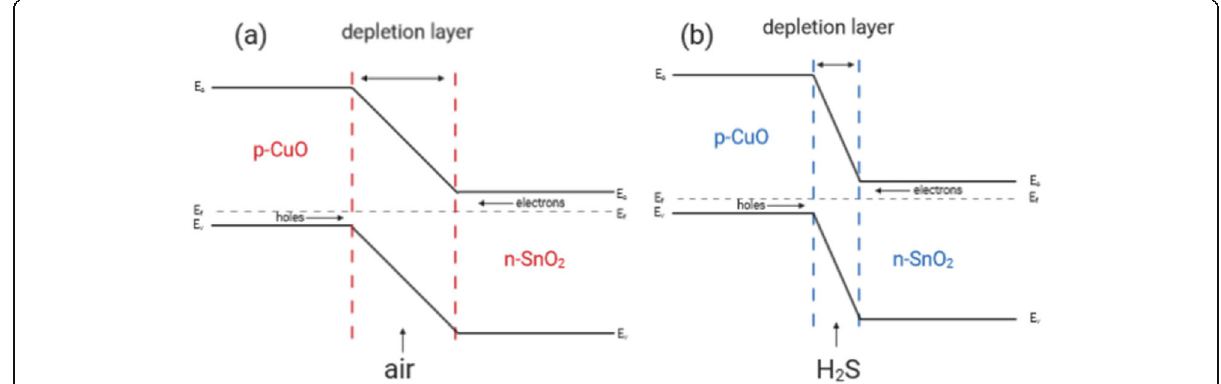
Fig. 9 a , b Sensing mechanisms of SnO 2 /CuO heterojunction for detecting H 2 S